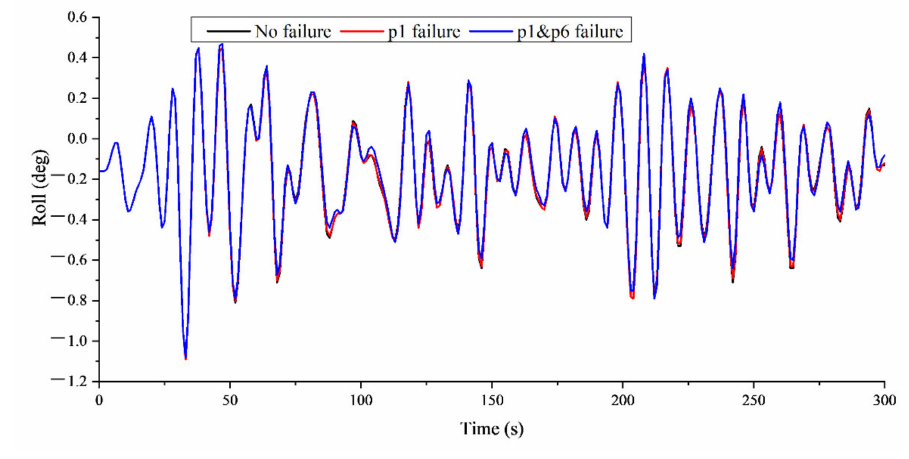
Figure 12. Roll under different failure conditions.